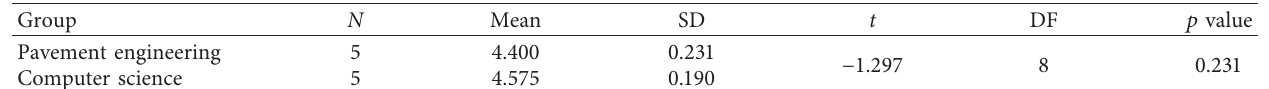
Figure 11: Screenshot of the asphalt pavement performance page. Table 5: Expert responses for evaluation statistically by t